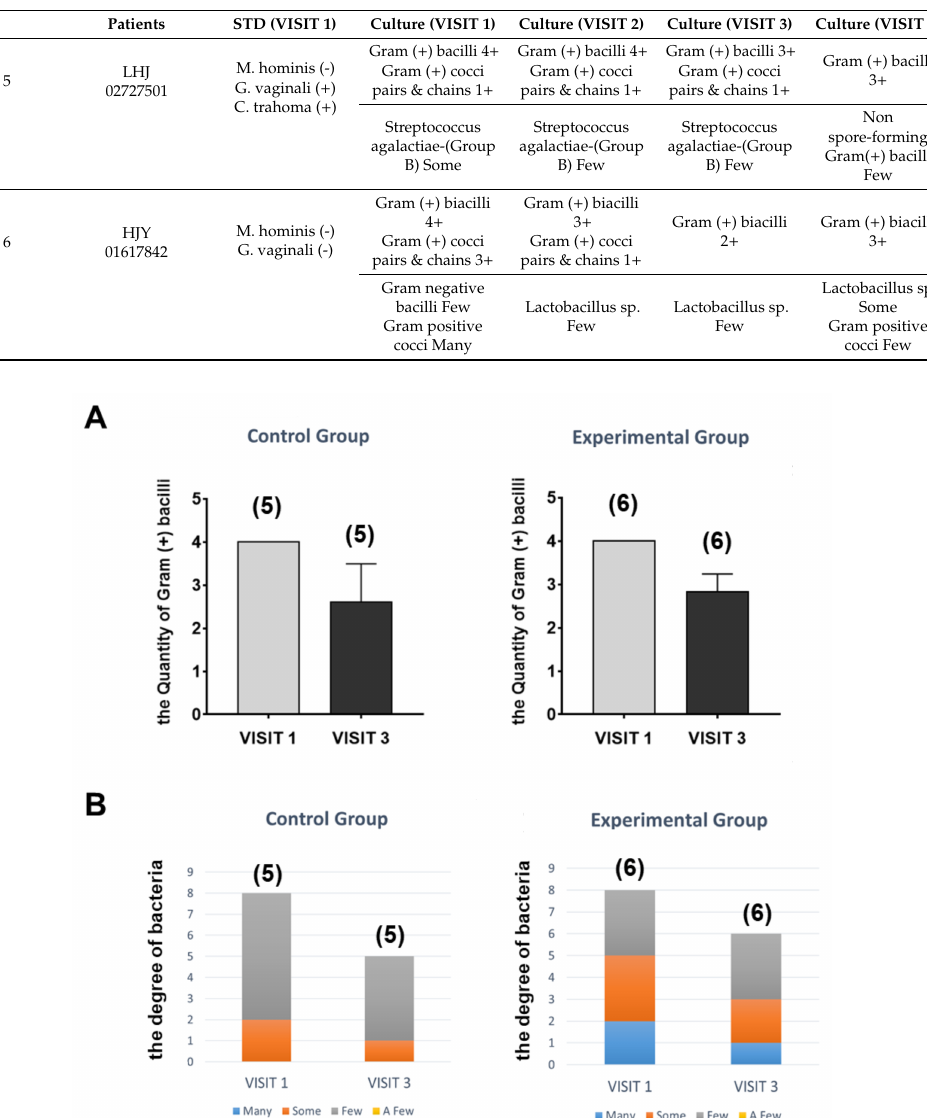
Figure 4. Therapeutic e ff ects of plasma-activated water from our device (experimental group) and betadine antiseptic (control group) on bacterial infection in patients with vaginitis. ( A , B ) The patients in experimental group showed a quantitative decrease in gram ( + ) bacilli ( A ) and the degree of bacterial contamination ( B ) similar to those of control group when compared between VISIT 1 and VISIT